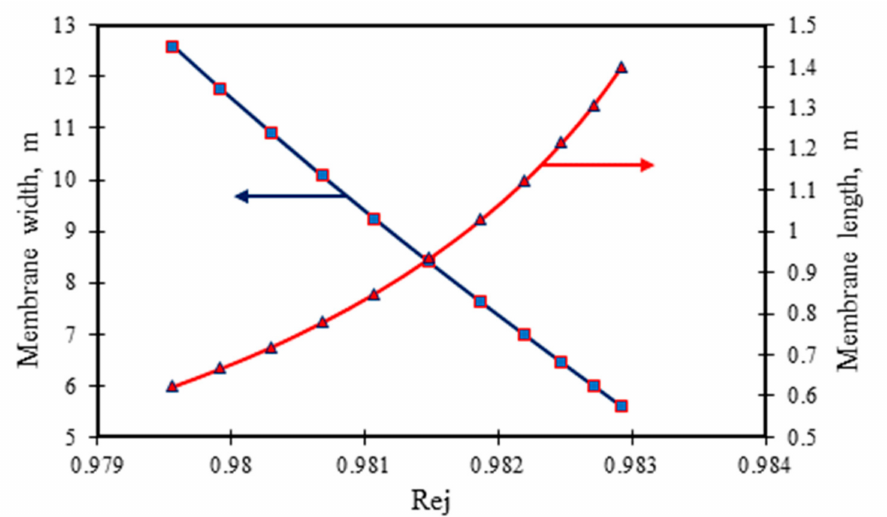
Figure 4. Influence of membrane module design parameters (length and width) on the re- moval of dimethylphenol at fixed membrane area and feed channel height (operating param- eters: ( A ) 6.548 × 10 − 3 kmol/m 3 , 2.583 × 10 − 4 m 3 /s, 13.58 atm and 31.5 ◦ C (adapted from Al- Obaidi et al. [24]).